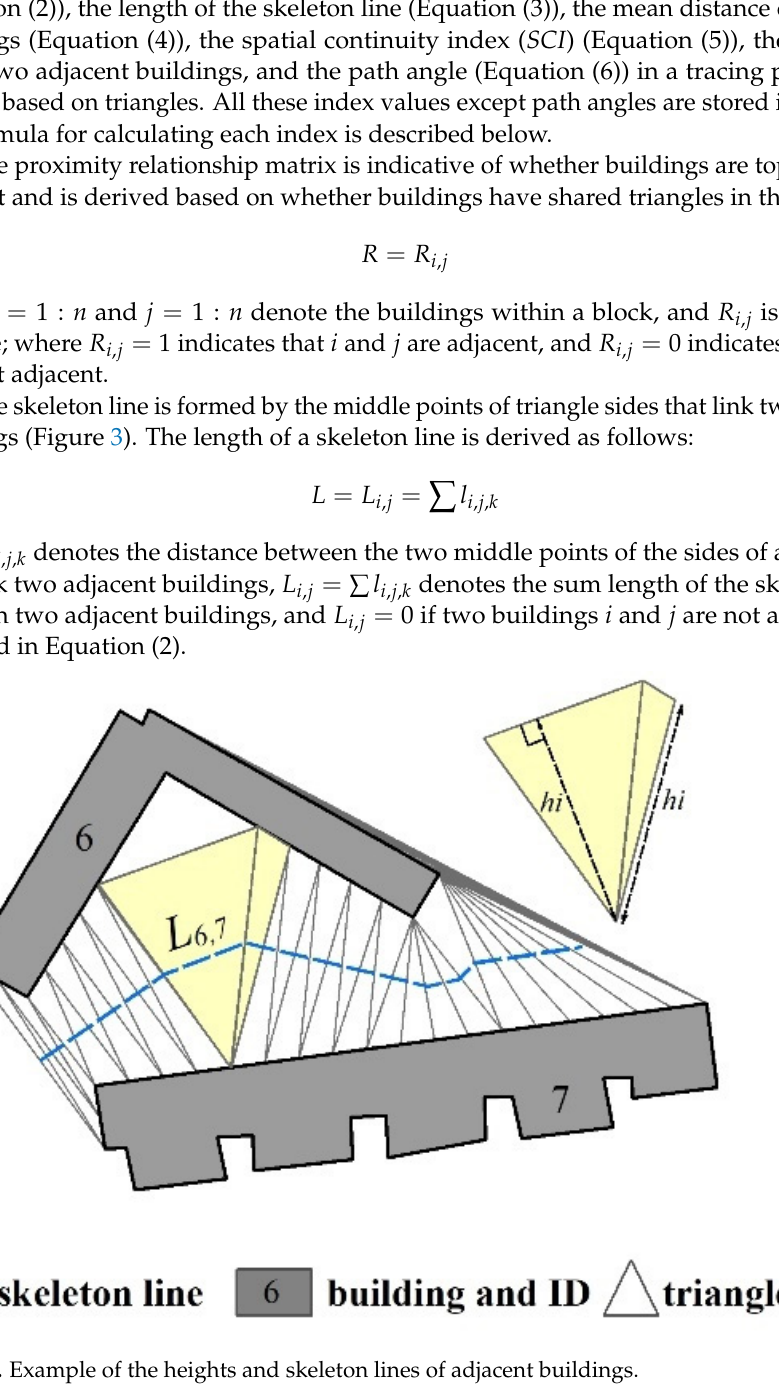
Figure 3. Example of the heights and skeleton lines of adjacent buildings.